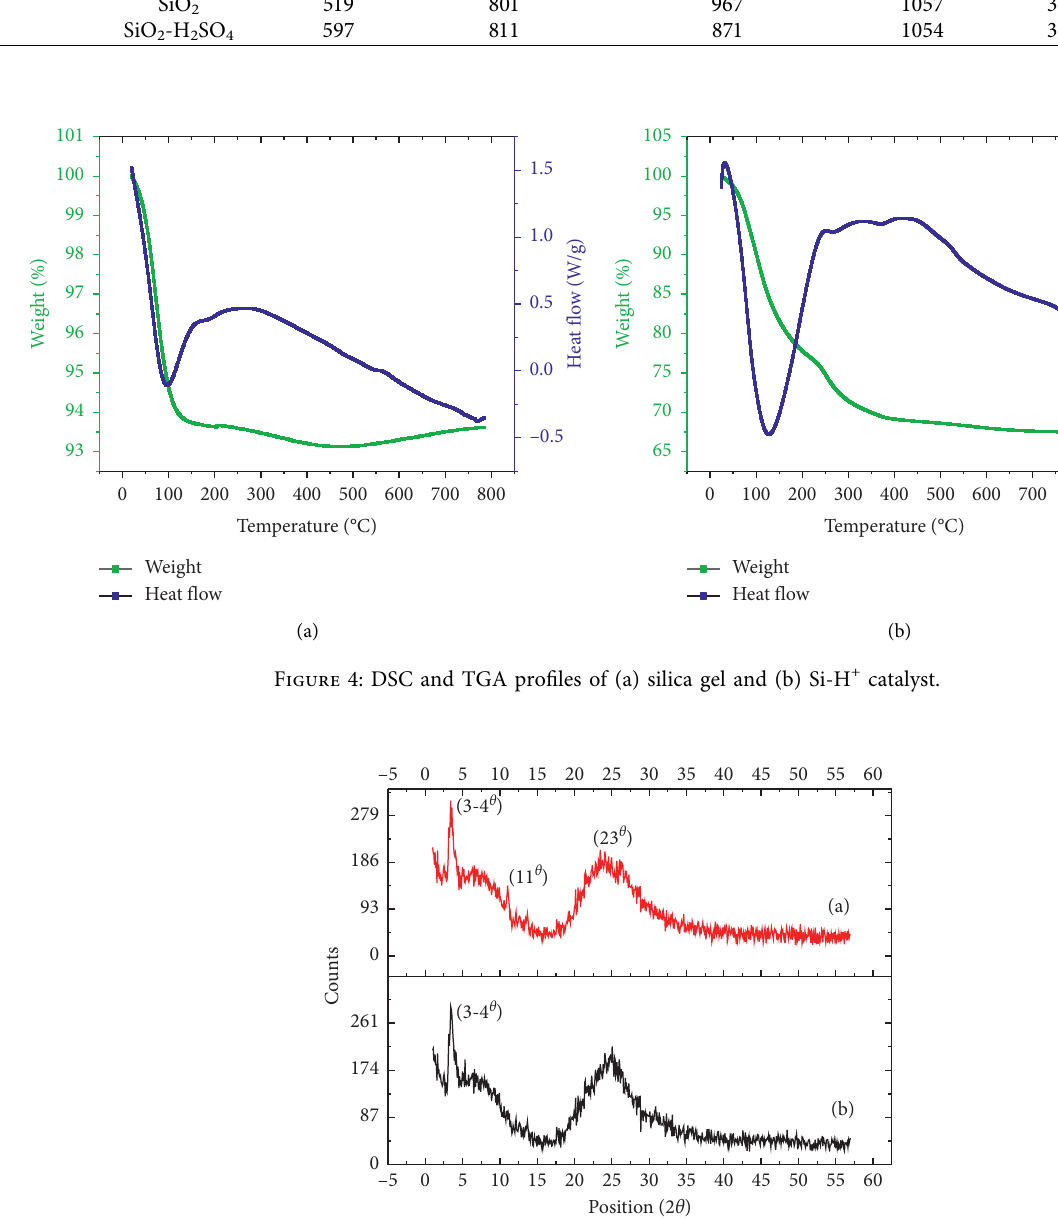
Figure 5: XRD patterns of (a) Si-H + catalyst and (b) silica gel.